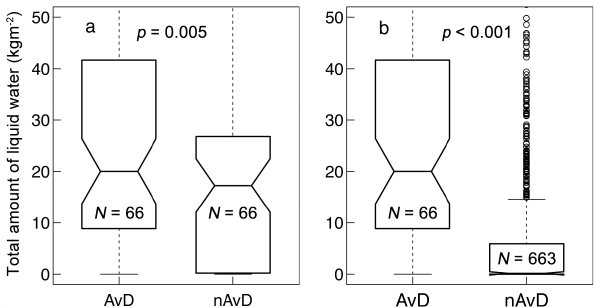
Fig. 1. Contrasting avalanche days (AvD) to non-avalanche days (nAvD) for the daily maximum amount of liquid water within the snowpack for (a) a subset of non-avalanche days and (b) all non- event days within the data set with data obtained from a simula- tion representing a south-facing slope. Boxes span the interquartile range, whiskers extend to 1.5 times the interquartile range. Outliers are shown with open circles. Notches are defined by ± 1.5 times the interquartile range divided by the square root of